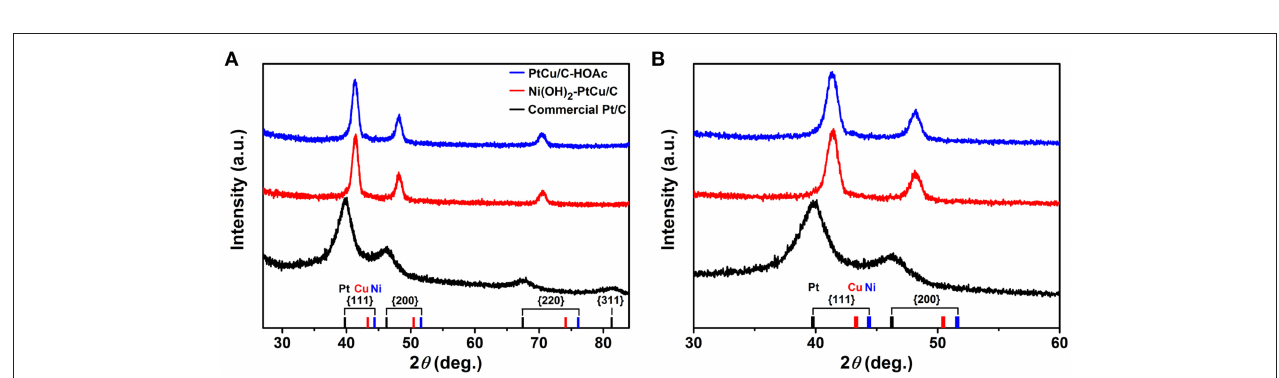
Frontiers in Chemistry |